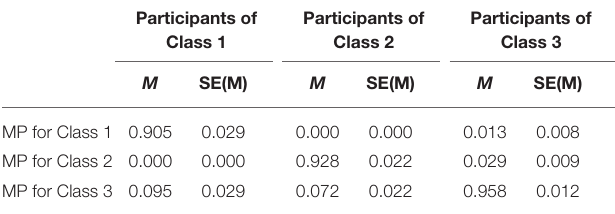
TABLE 4 | Mean class membership